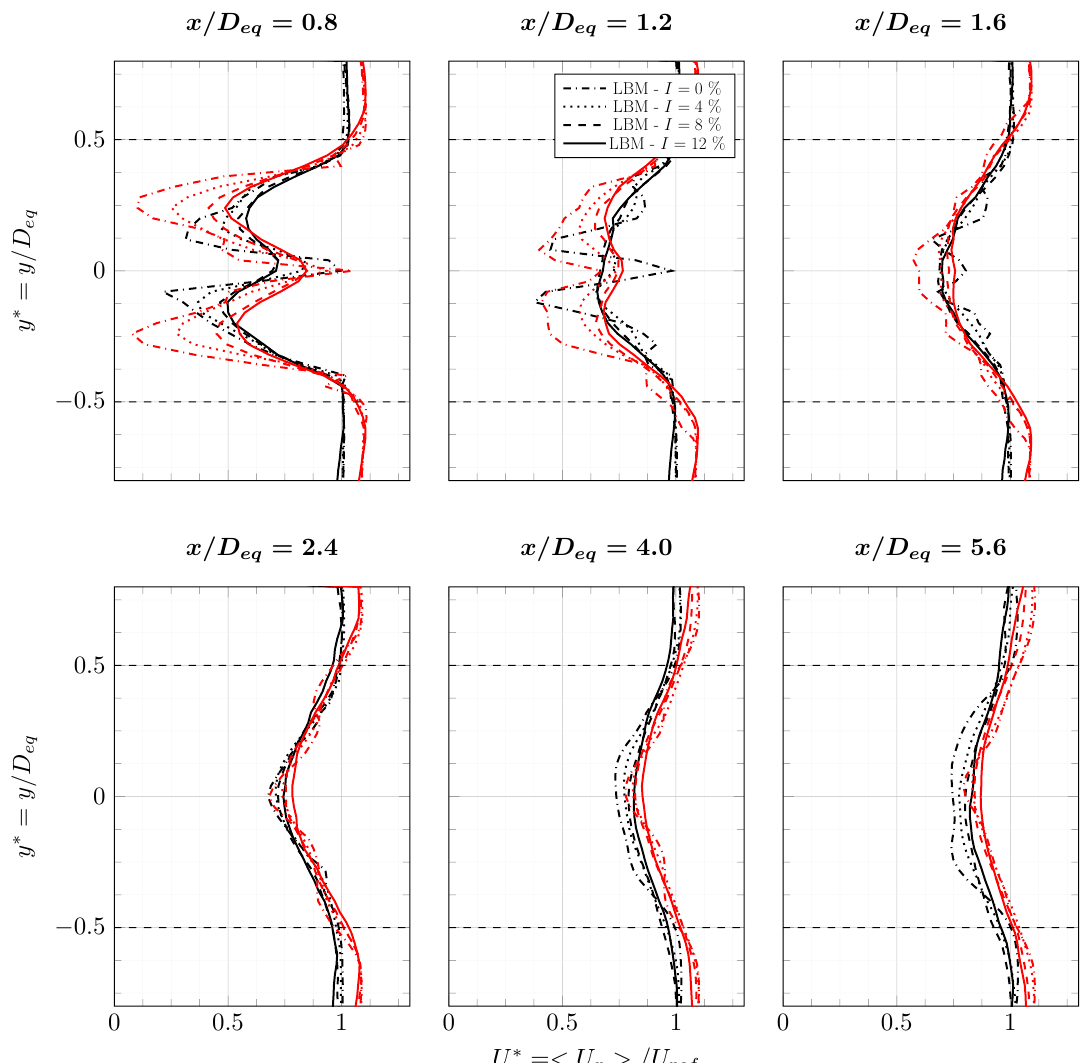
Figure 17. Average axial velocity y profiles in the wake of the tidal turbine at TSR = 1.5. ALM-LBM results for the four turbulence rates. Black curves are extracted at the bottom rotors mid-height. Red curves are extracted at the top rotors mid-height. Turbine footprint is drawn in horizontal black dashed lines. Dimensions are scaled by the equivalent diameter D eq = 25.0